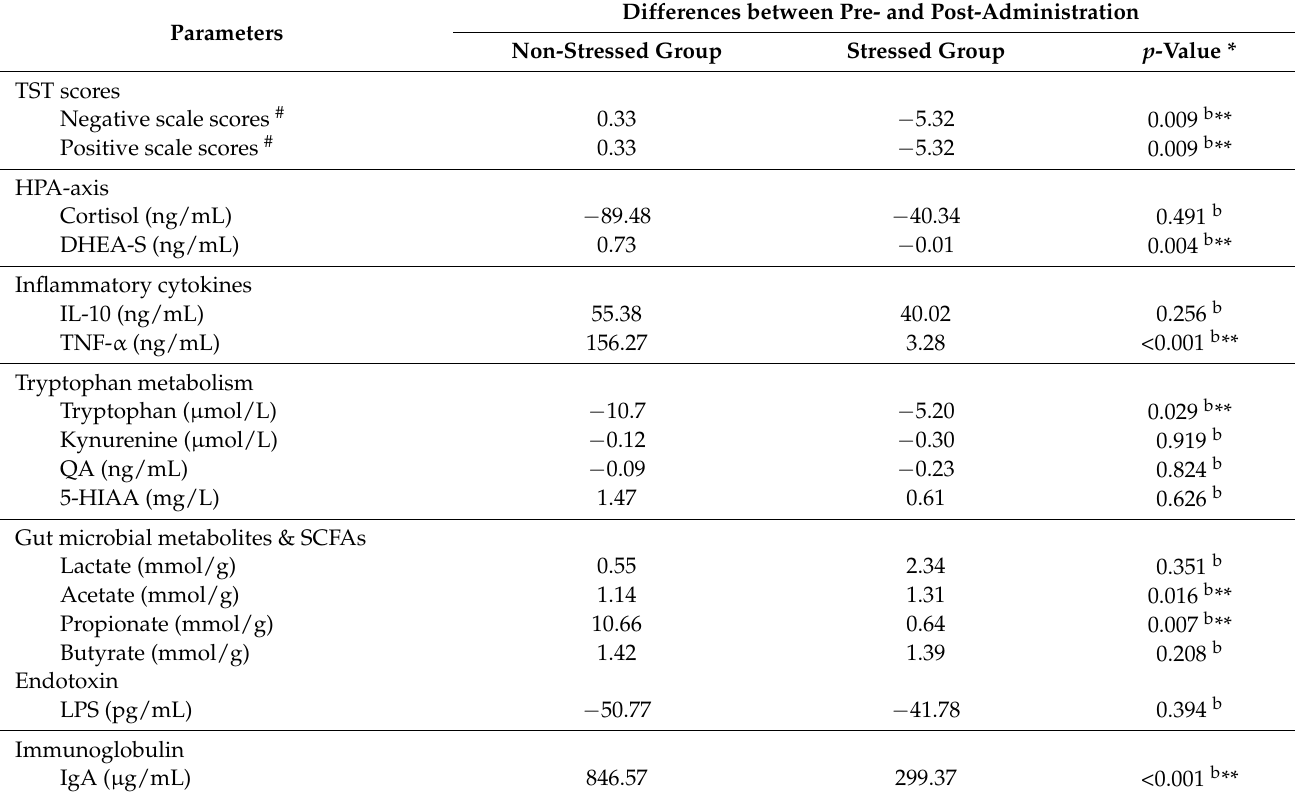
Table 3. Comparison of the differences between pre- and